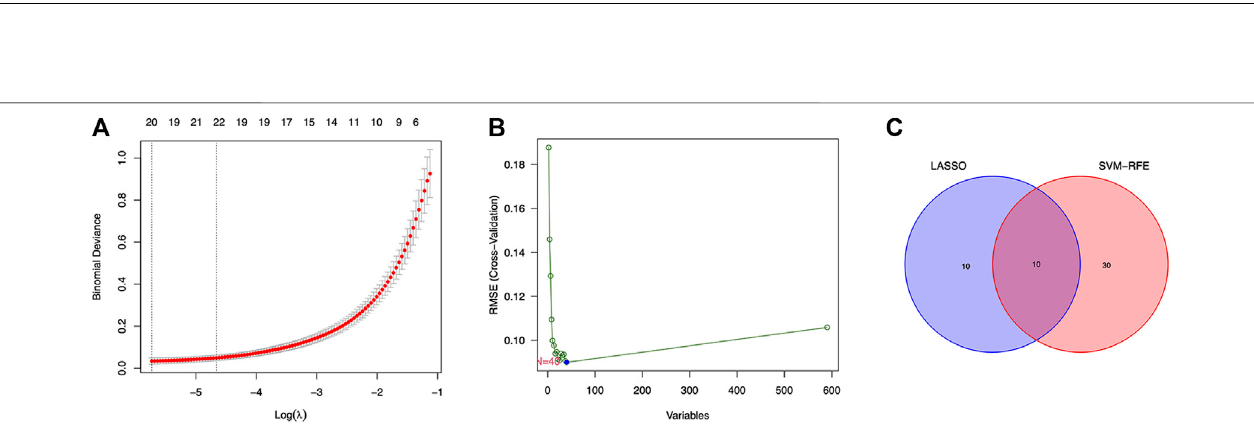
FIGURE4| LASSOandSVM-RFEscreencharacteristic genes. (A) LASSOregressionscreensdiseasecharacteristicgenes,theabscissaislog λ ,andtheordinate isthecross-validation error. When20genesareselected, thecross-validationerroristhesmallest. (B) SVM-RFE screens characteristic genes.Theabscissarepresents the change in the number of genes, and the ordinate represents the cross-validation error. When n = 40, the cross-validation error is the smallest. (C) Venn diagram shows the intersection of genes found by two machine learning methods.